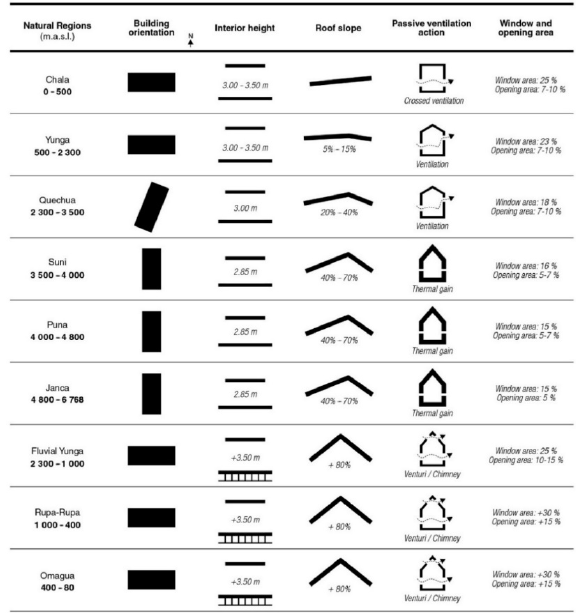
Figure 8. Design Guidelines according to the Natural Regions of Peru (source: author, elaboration based on Rayter, 2008 )